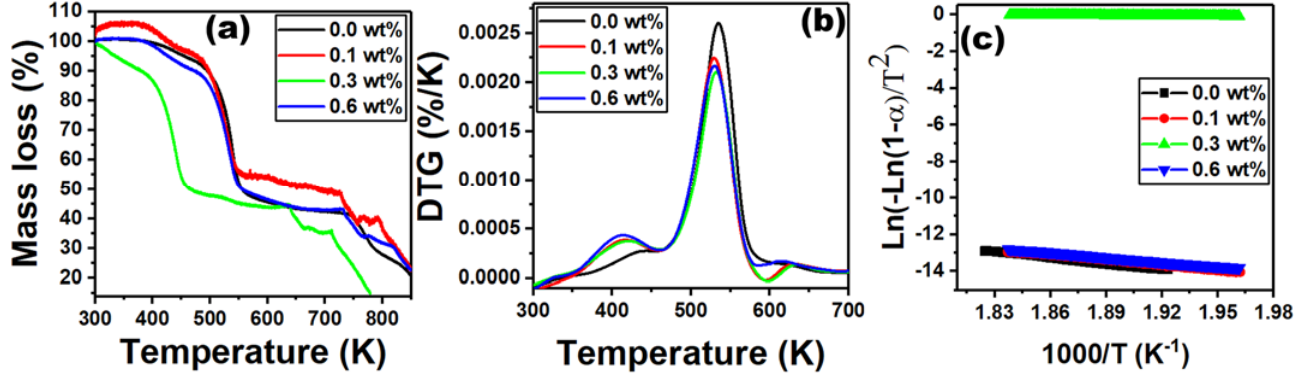
Figure 5. Representation of ( a ) TGA data plots, ( b ) DTG plots and ( c ) Coats–Redfern graphs for PVC/PVP doped with Er 2 O 3 at different concentrations of 0.0, 0.1, 0.3 and 0.6 wt % .